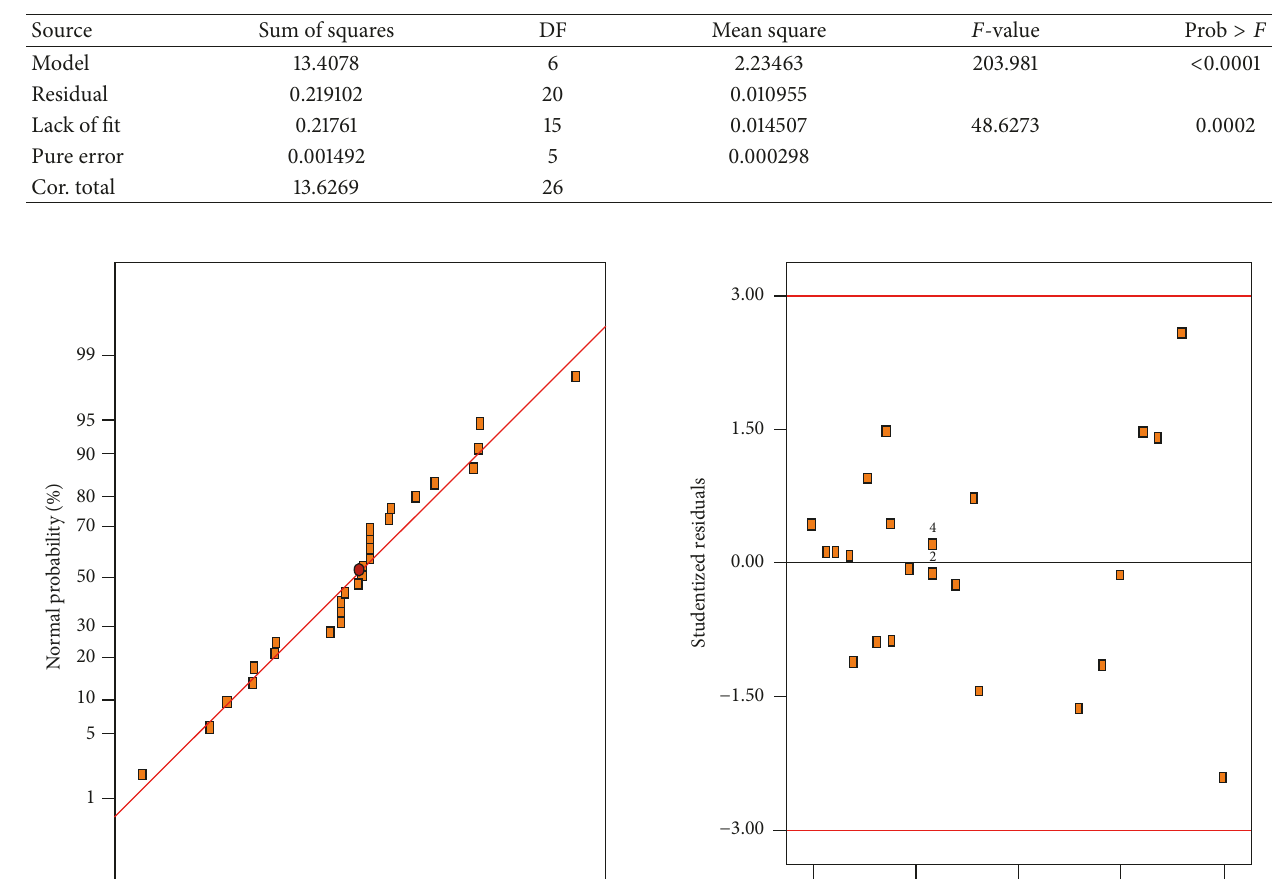
Table 4: Results for ANOVA for the model.